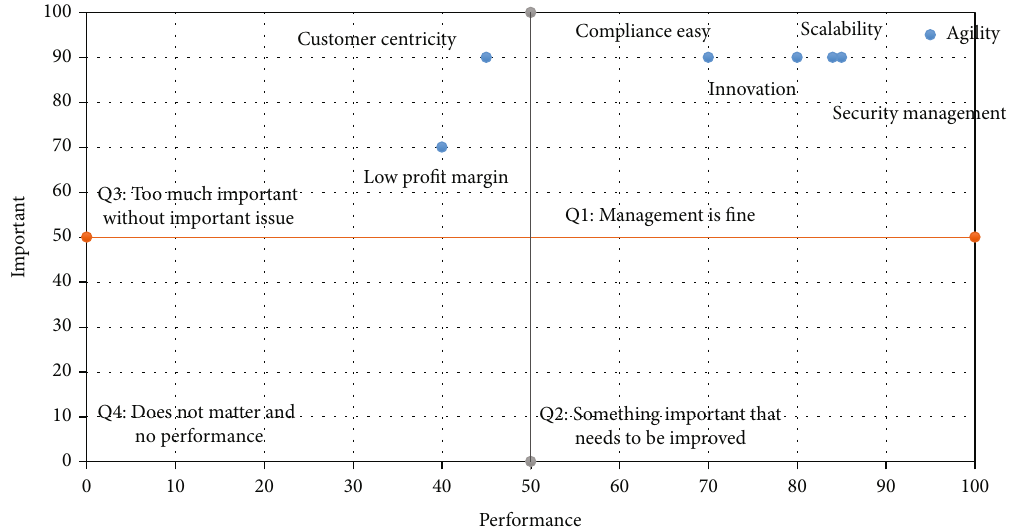
Figure 4: Importance performance map